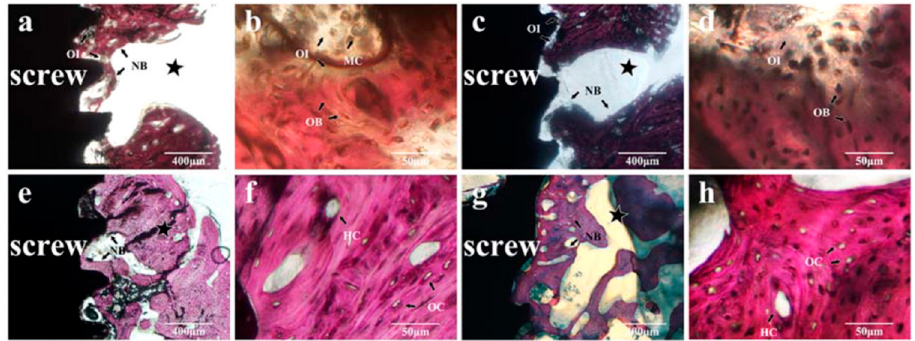
Figure 2. Histological morphologies of implanted C-JDBM ( a , b , e , f ) and 316L ( c , d , g , h ) screws and bone tissue after 1 ( a – d ) and 4 ( e – h ) months of implantation. NB: new bone, OI: osteoid, MC: multinucleate cell, OB: osteoblast, HC: haversian canal, OC: osteocyte, asterisk: artificial defect. Reproduced with permission from [71], American Chemical Society, 2014.